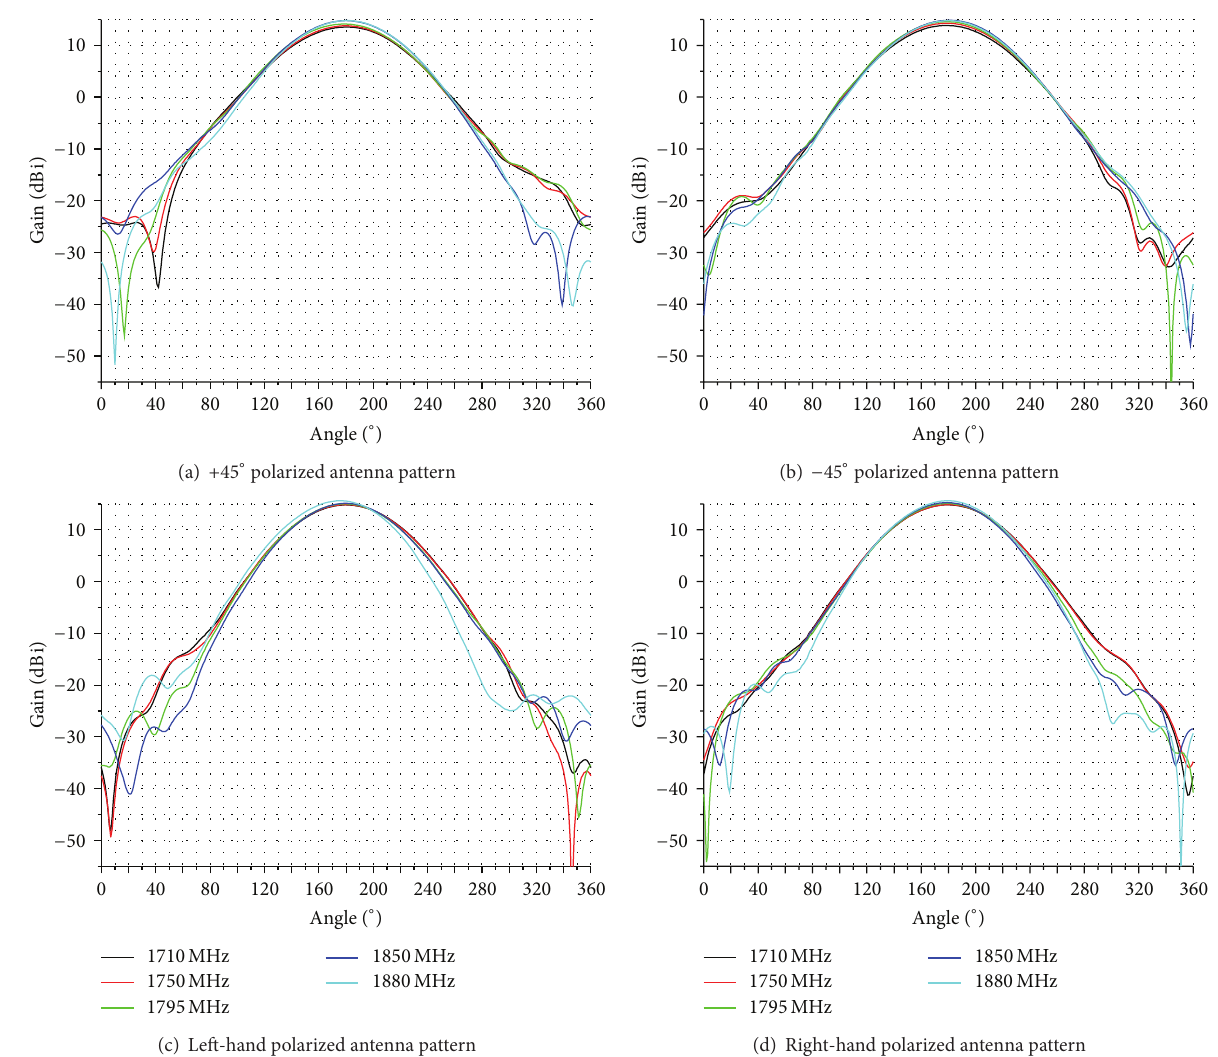
Figure 7: Comparison of pattern between linear polarized antenna and circular polarized